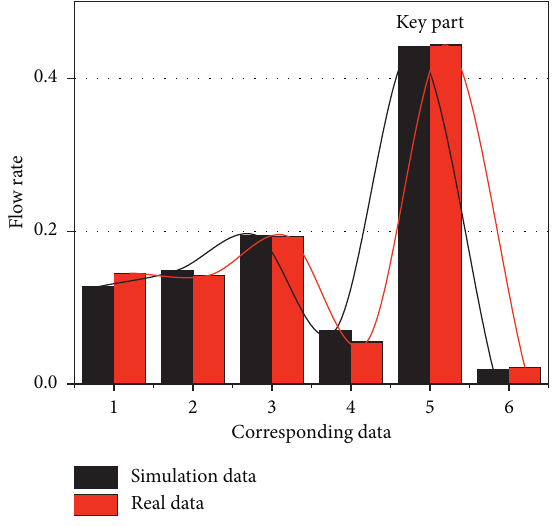
Figure 7: Corresponding data